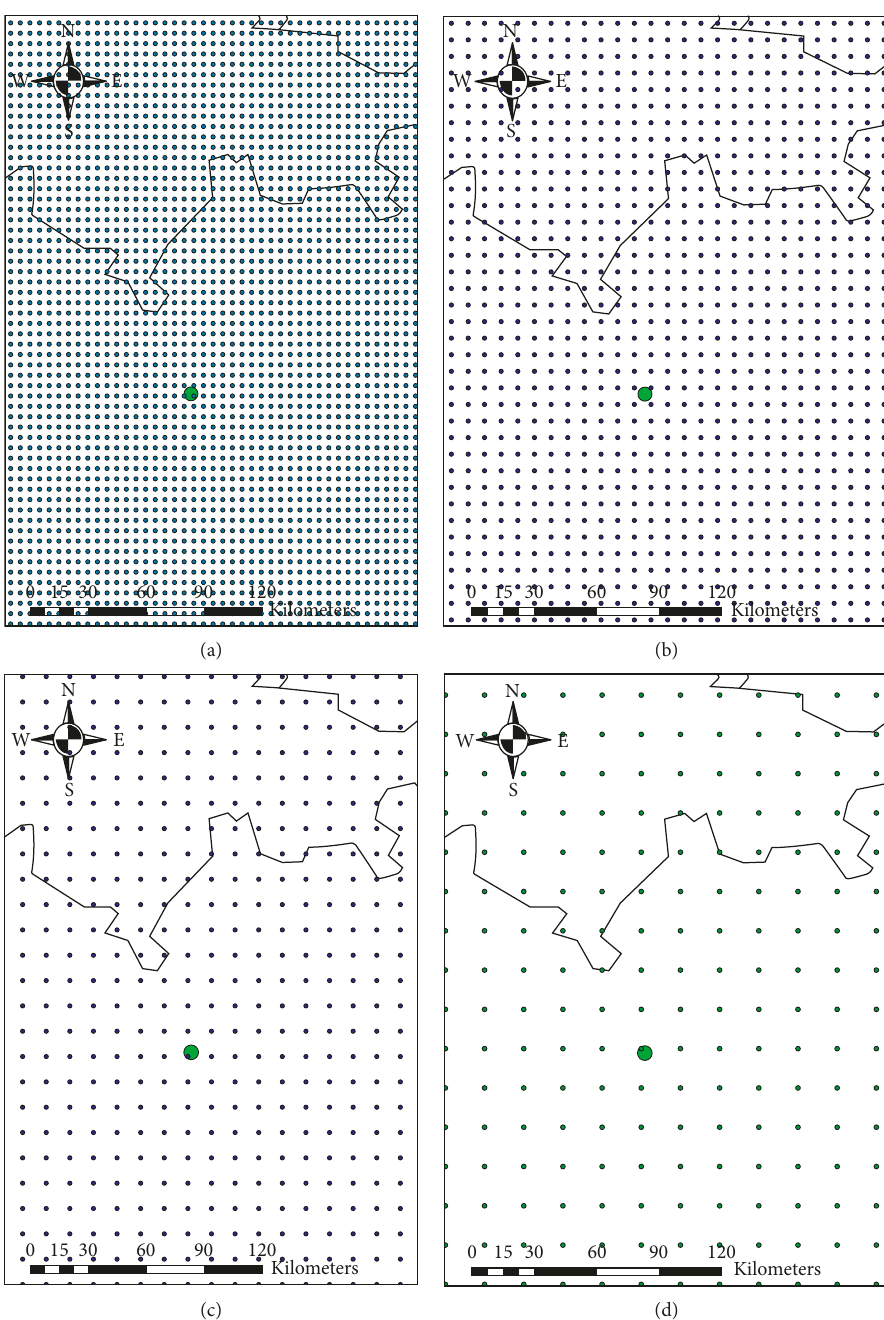
Figure 3: Example of the four grid domains: 5.5km (a), 8 km (b), 13km (c), and 18km (d) of the e-kmf ™ model; the green dot shows the city centre of Milano in the north of